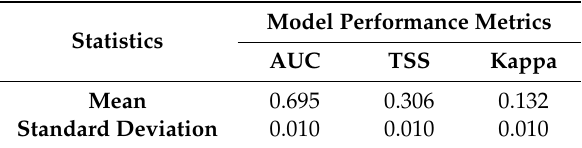
Table 4. Summary statistics of model performance from multiple habitat model simulations using the BIOMOD2 package in R. The statistical metrics were comprised of threshold-independent (AUC and TSS) and –dependent (Kappa) performance